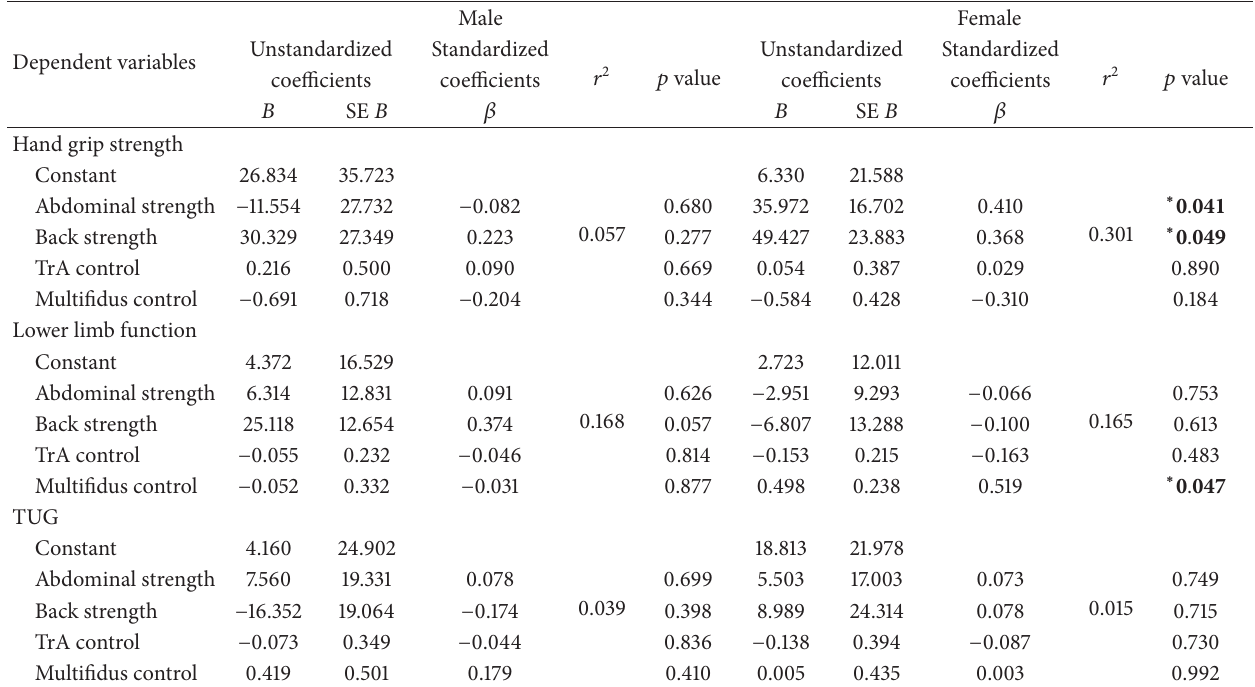
Table 3: Multiple linear regression of functional performances and muscle